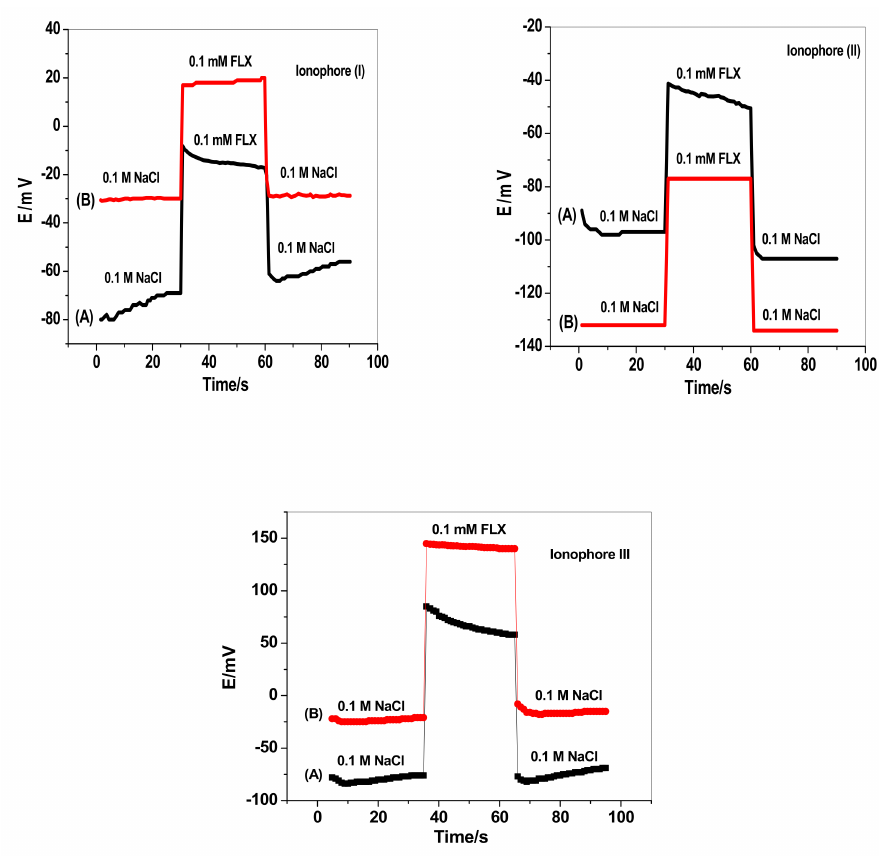
Figure 4. Water layer tests for ( A ) non-modified, ( B ) and modified FLX sensors based on ionophores I, II, and